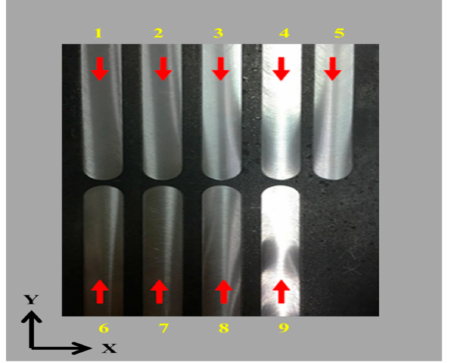
Figure 2. Milling sequence and direction on work piece (yellow number: milling sequence; red arrow: milling